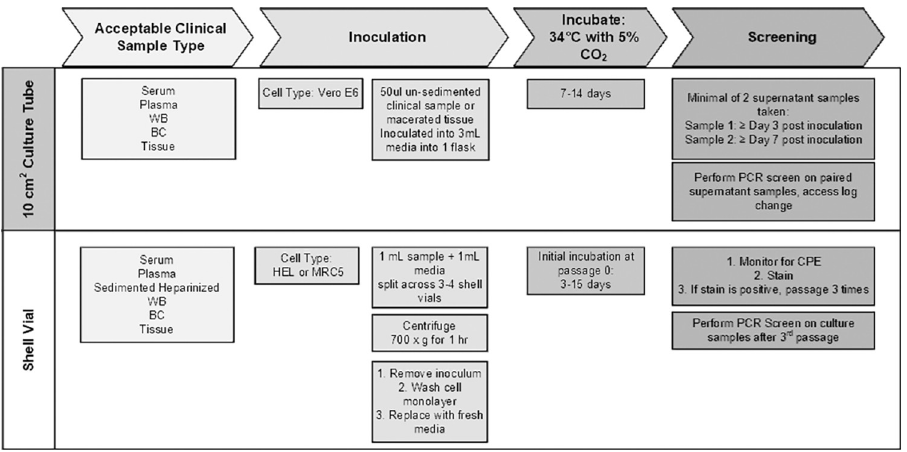
Fig 5. Clinical Isolation Method